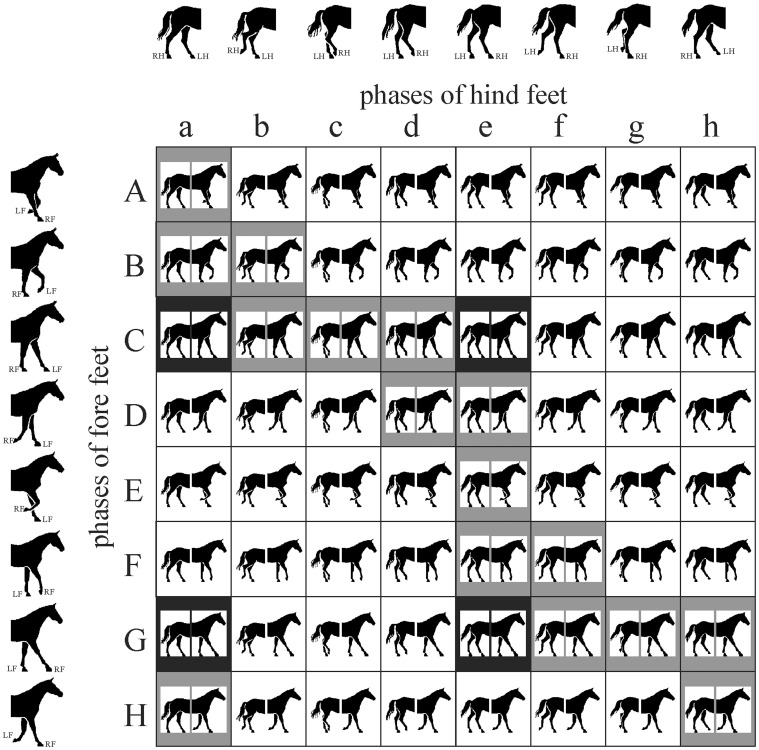
The 8×8 walking matrix of the stride of the horse walking from left to right.To each of the 8 columns and 8 rows belong given postures of the hind and fore feet pair, respectively, as shown by the black half horse contours on the top and left border. These horse contours coincide with the scientific drawings of the eight phases of the stride of walking horses published by Gambaryan [11], [12]. In a given cell of the matrix the fore feet attitudes belonging to the cell’s row are paired with the hind feet postures belonging to the cell’s column.